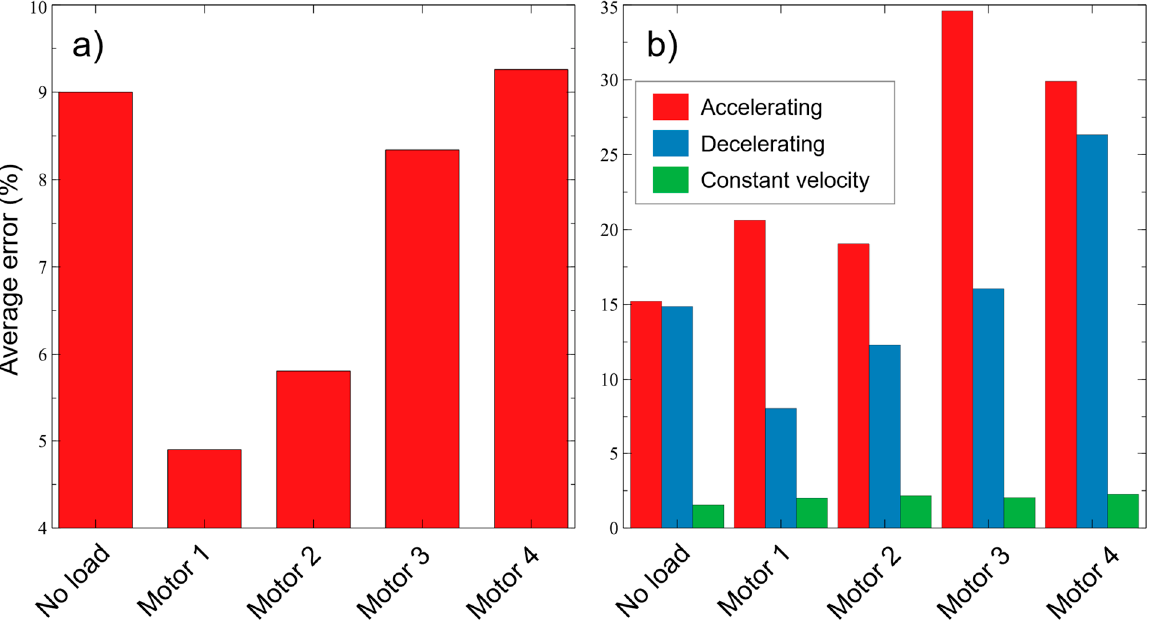
Figure 6. Average error ( a ) as a whole and ( b ) broken down based on the motion phases, i.e., accelerating, decelerating, and constant velocity.